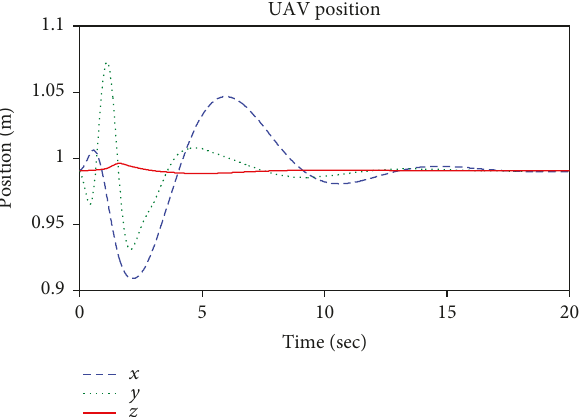
Figure 15: Interaction force between the end e ff ector and the surface.